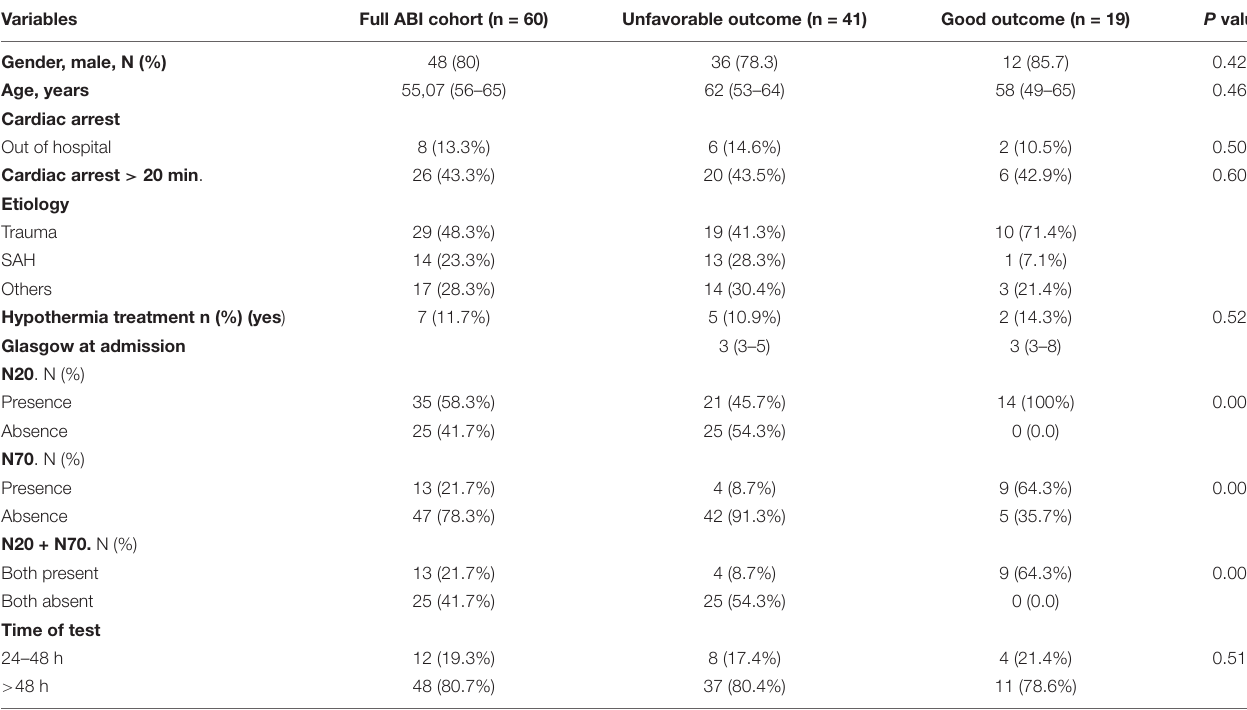
TABLE 4 | Characteristics of the study population in acute brain structural injury ( n = 60). Variables Full ABI cohort (n = 60) Unfavorable outcome (n = 41) Good outcome (n =